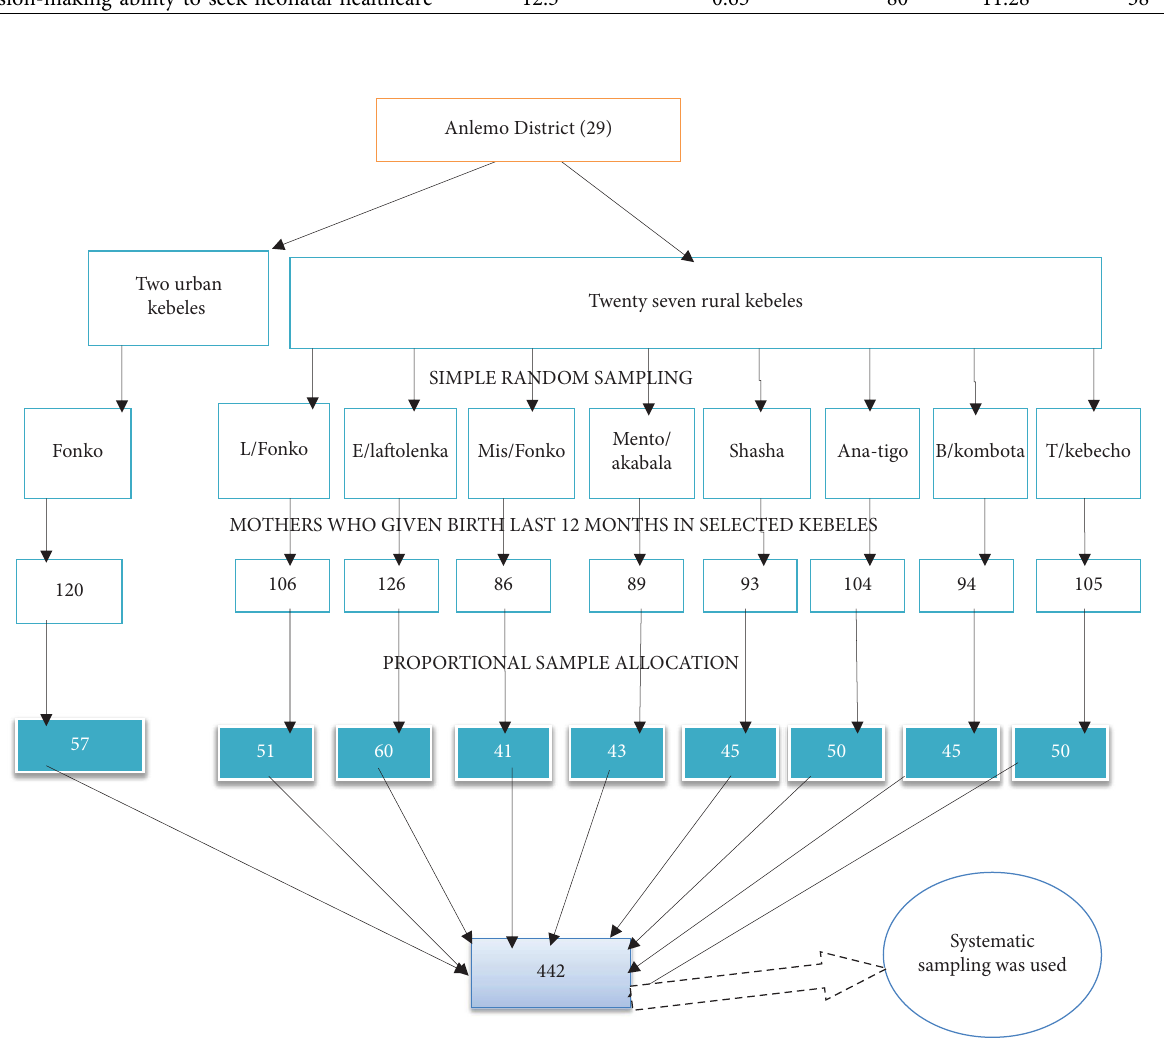
Figure 1: Schematic presentation of sampling procedure.